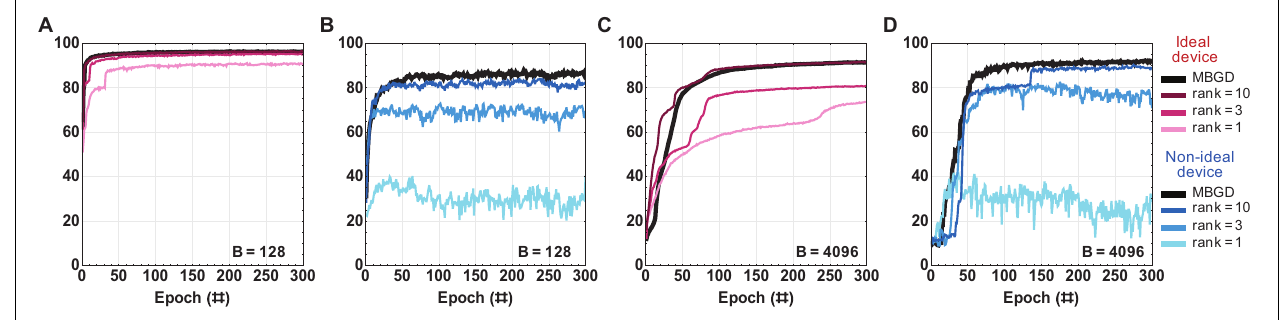
FIGURE 9 | The rank-seq NMF results for a multi-layer perceptron with ideal vs. non-ideal memristive weights at different ranks and batch sizes. (A,B) Convergence curves using the rank-seq weight transfer method at batch size = 128; and similarly (C,D) at batch size = 4096. The results show that the NMF using rank-seq transfer method can approximate the MBGD results well at high ranks. For all these experiments, the rounding method is stochastic.